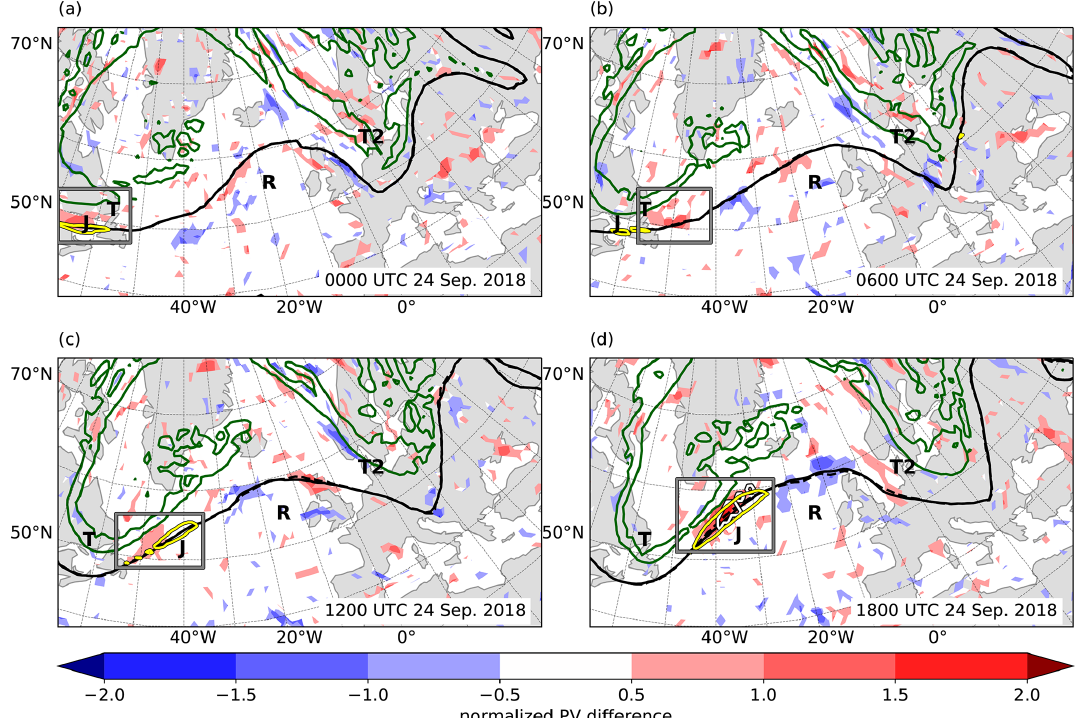
Figure 9. Normalized PV differences between clusters E and W ( (cid:49) PV EW , shaded), 2PVU contour (black lines) of clusters E (solid) and W (dashed), 9PVU contour (green lines) and wind speed (yellow lines, 70ms − 1 ) in the operational analysis at 325K from 00:00UTC 24 September to 18:00UTC 24 September 2018, every 6h. Regions with statistically significant PV differences ( α fdr < 0 . 1, single isolated significant grid points are removed) are marked with white contours, and grey boxes mark the regions of interest (for details see